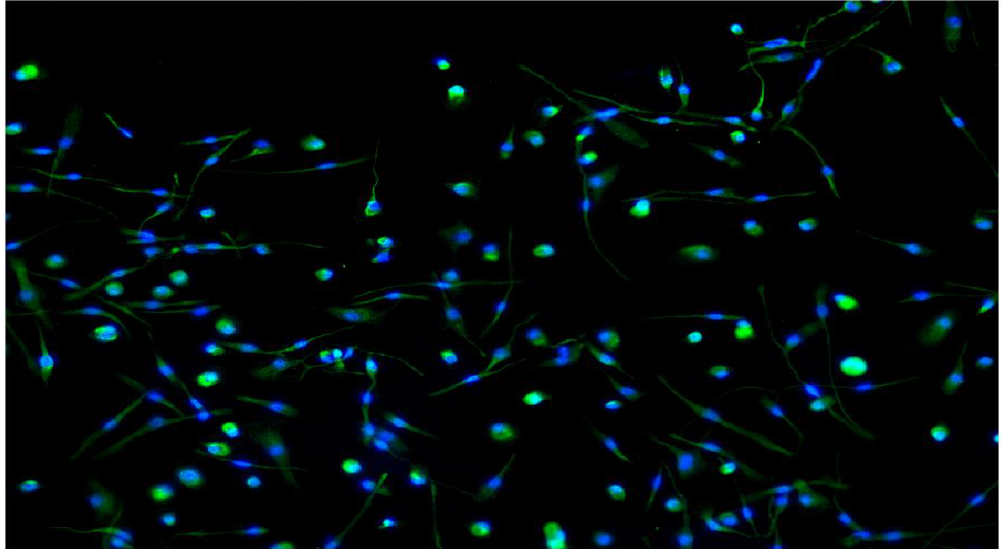
Figure 3. The positive expression of CD14 by immune-fluorescence analysis, which is considered to be a typical marker for the identification of macrophages. After a 7-day culture, the cells were fixed with 4% paraformaldehyde for 15 min, permeabilized with PBS (1×) containing either 0.1% Triton X-100, labeled with anti-CD14 (green stain CD14 expression with Alexa Fluor 488) polyclonal antibody at a dilution of 1:50, followed by a goat anti rabbit Alexa Fluor ® 488 secondary antibody to visualize the membrane. Images were assessed by inverted microscopy (Axio Observer Z1, Zeiss, resolution 100×). Nuclei were stained with DAPI. As a consequence of the growth factors used, GM-CSF led to a majority of elongated, fibroblast-spindle like shaped cells, and similar to macrophages existent in lung alveoli, in contrast the presence of M-CSF induced a majority of round or oval macrophages (fried eggs) like peritoneal macrophages.